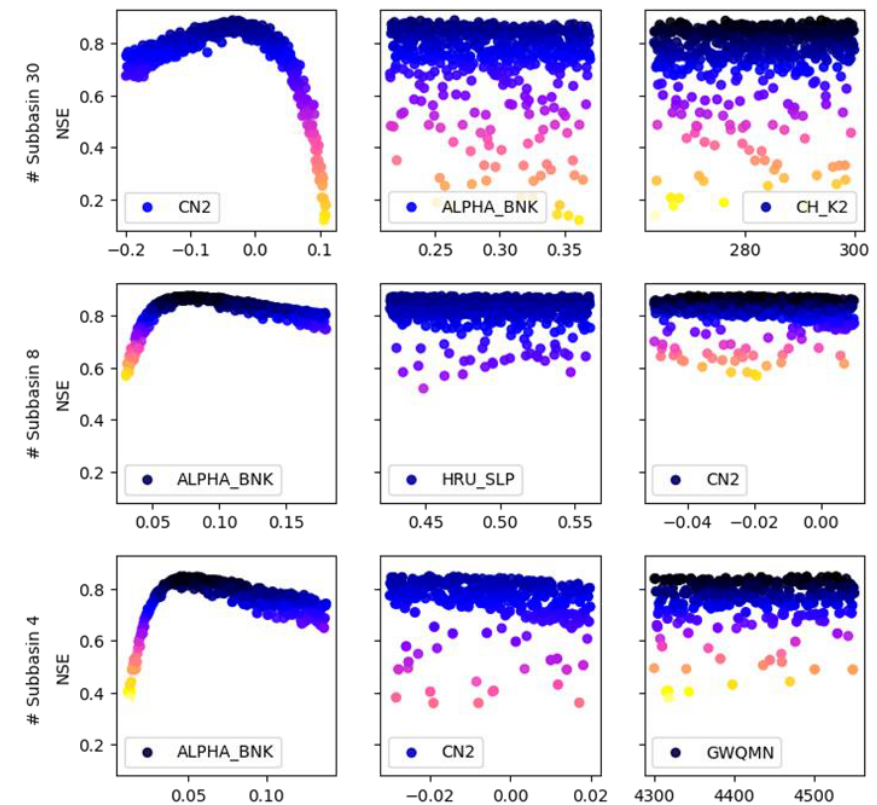
Figure 5. Dotty plots of the coefficient of NSE against SWAT parameters (left columns represent the most sensitive) using SUFI2 based on 500 samples from the Abelti watershed. (Note that # Subbasins 30, 8, and 4 account for 2%, 10%, and 20% of the Abelti watershed area, respectively.).